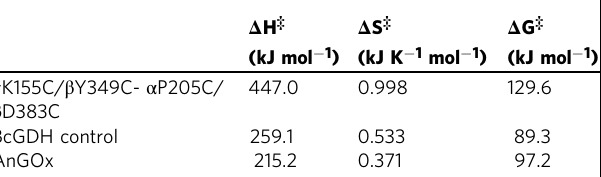
Fig. 4 Thermal inactivation of the quaternary structure engineered BcGDH, BcGDH without additional disul fi de bonds, and glucose oxidase derived from Aspergillus niger (AnGOx). a – c Time courses of thermal inactivation for a the quaternary structure engineered BcGDH, b BcGDH without additional disul fi de bonds, and c glucose oxidase derived from Aspergillus niger (AnGOx) ( n = 3). d Eyring plot analyses of thermal inactivation based on the fi rst order rate constant of thermal inactivation ( k in ) obtained from ( a – c ). Numerical Data for Fig. 4a – d can be found in Supplementary Data 2. Table 3 Calculated activated parameters of thermal inactivation from regression analysis of Eyring plot (45 ˚